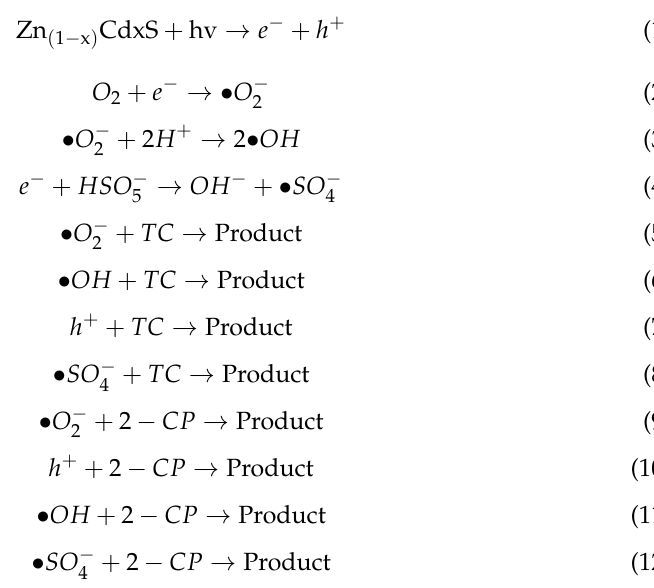
Figure 12. Possible photocatalytic mechanism of photocatalytic TC degradation and 2-CP degrada- tion.